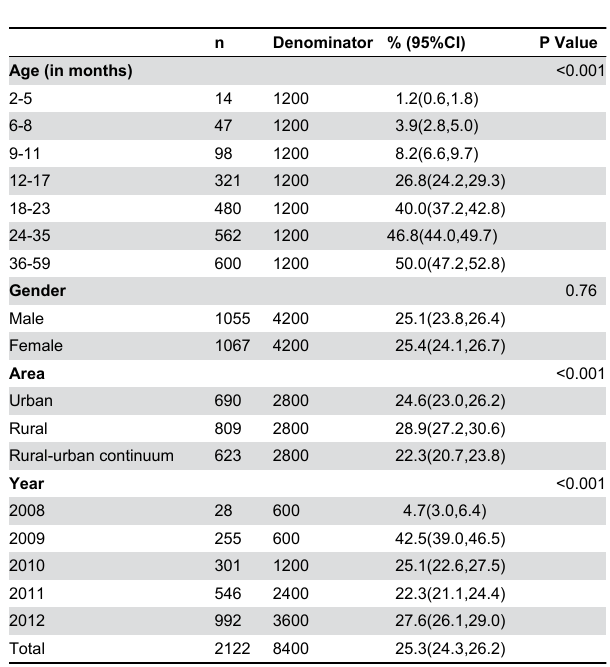
Table 1. LLR vaccination coverage among children ages 2-59 months in Guangzhou * .